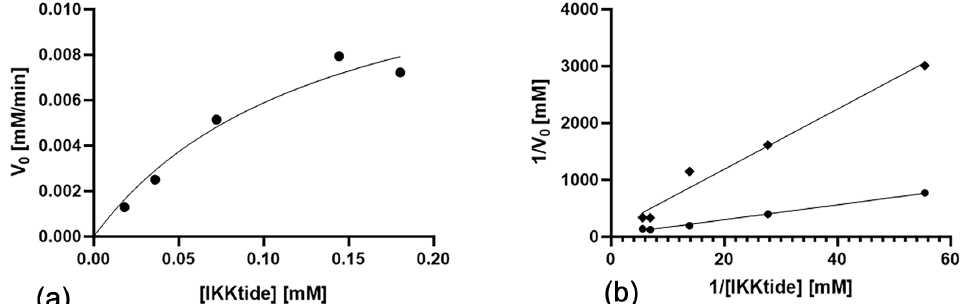
Figure 4. Michaelis-Menten and Lineweaver-Burk fitting. ( a ) several concentrations (ranging from 0.0175 mM to 0.175 mM of IKKtide were analyzed in the in vitro kinase assay as described in the text, to calculate the Km and the Vmax; ( b ) to calculate the Ki, same concentration of IKKtide were used in the in vitro assay in absence (circles) and in presence (squares) of 0.5 mM NAPA (corresponding to IC 50 ). K m , V max and K i were calculated with GraphPad Prism software (N =